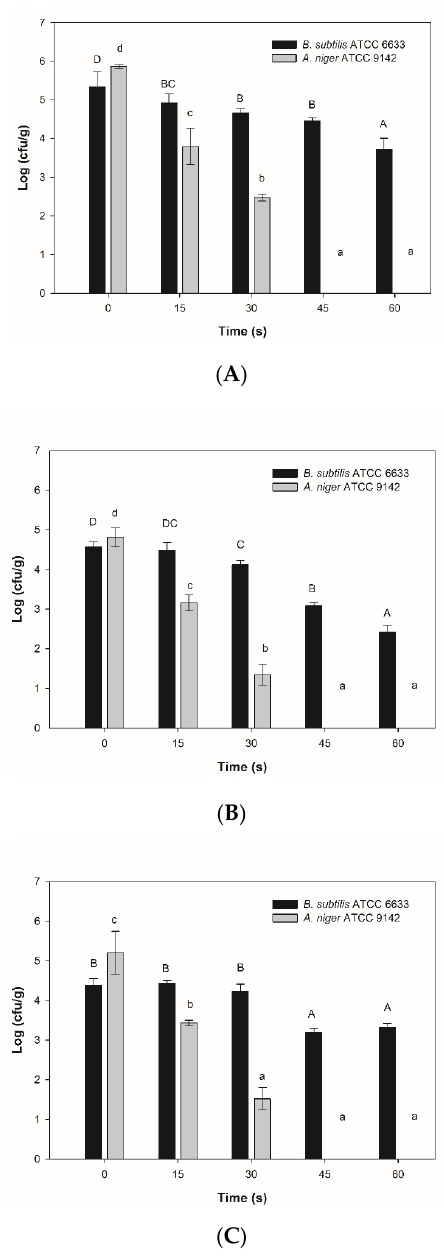
Figure 6. The results of microbiological analysis of untreated and plasma-treated inoculated ( A ) black pepper seeds, ( B ) juniper berries and ( C ) allspices berries. The same capital or small letters indicate homogenous groups ( α = 0.05) for bacteria and molds growth results, respectively. n =